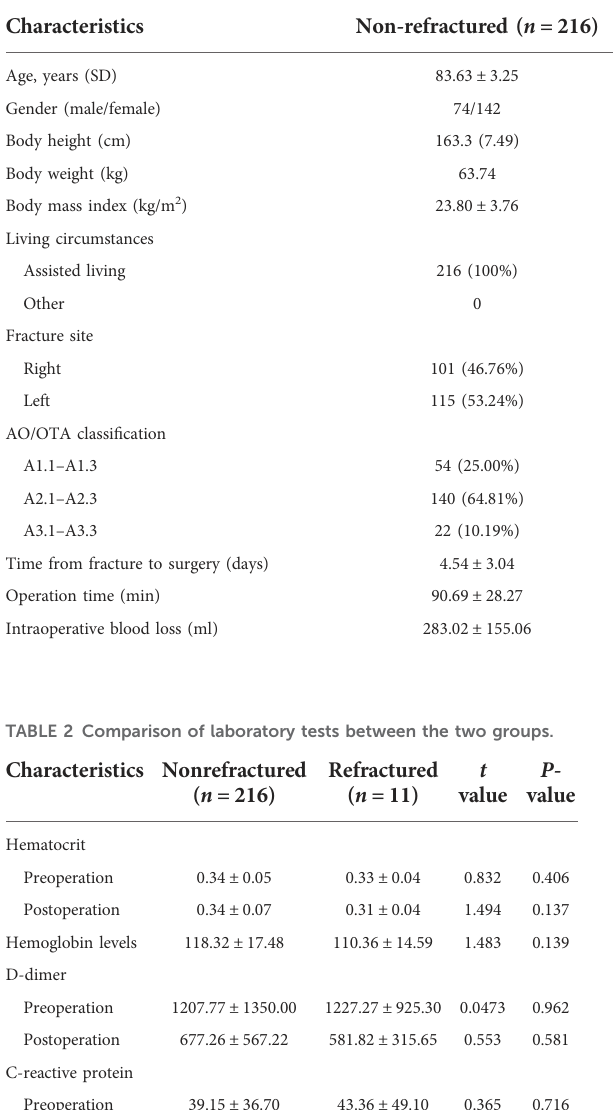
TABLE 4 Univariate and multivariate analyses of